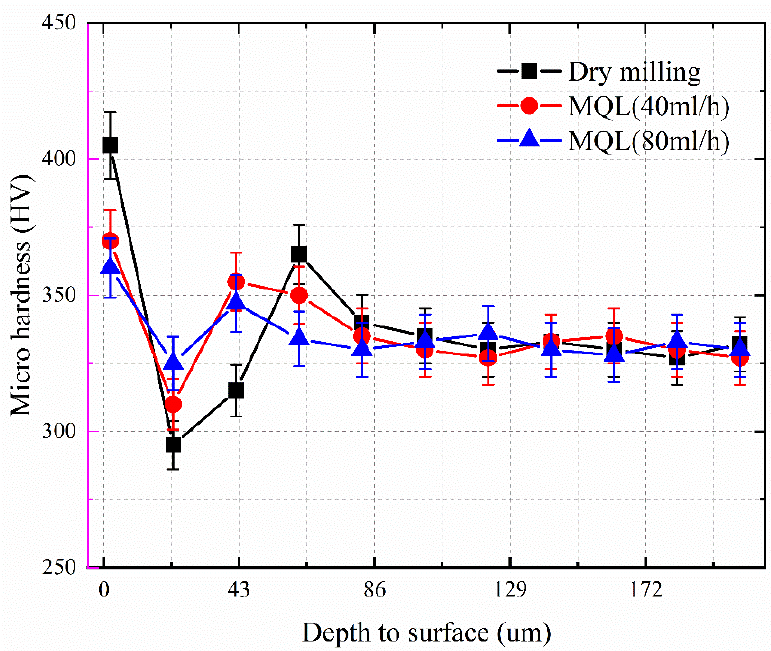
Figure 21. The microhardness distribution of the surface layer.